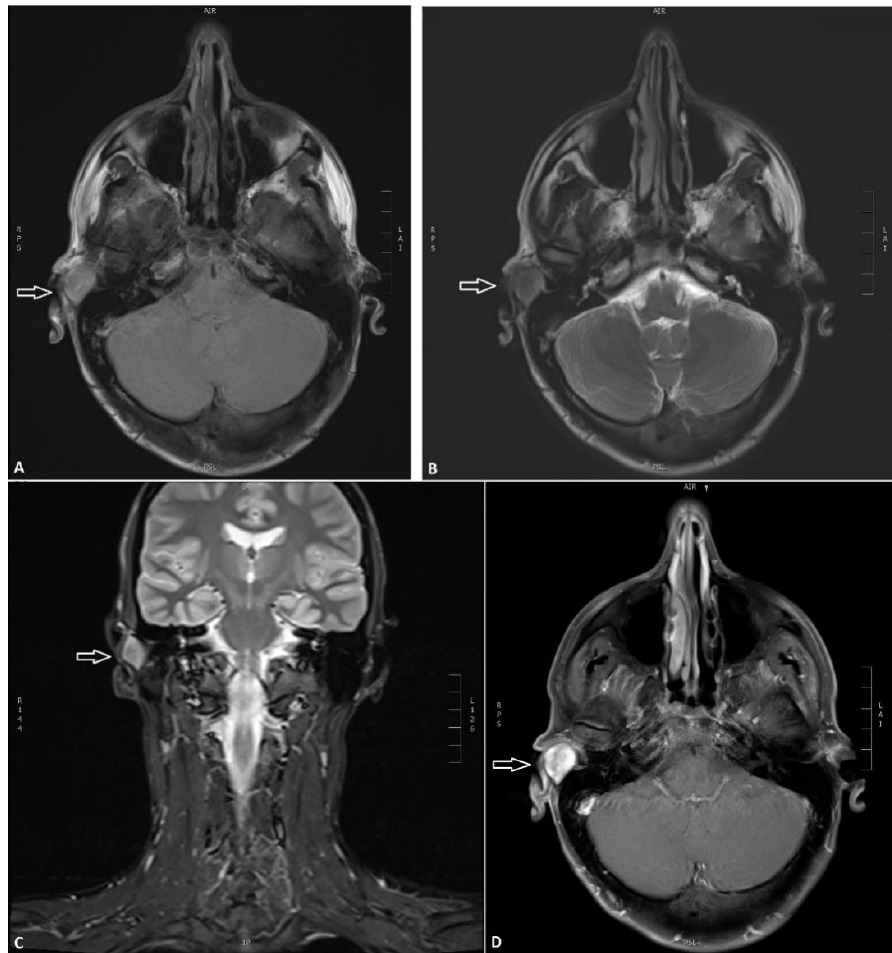
Figure 1. Initial MR scanning. ( A ) Axial T1-weighted MR showing a slightly hyperintense tumor with a retroauricular location on the right side (arrow). ( B ) Axial T2-weighted MR showing inhomogeneous signal corresponding to the tumor. ( C ) Coronal short tau inversion recovery (STIR) with the slightly hyperintense tumor. ( D ) Axial contrast-enhanced T1-weighted MR showing a strong contrast enhancement of the tumor with some central non-enhancing